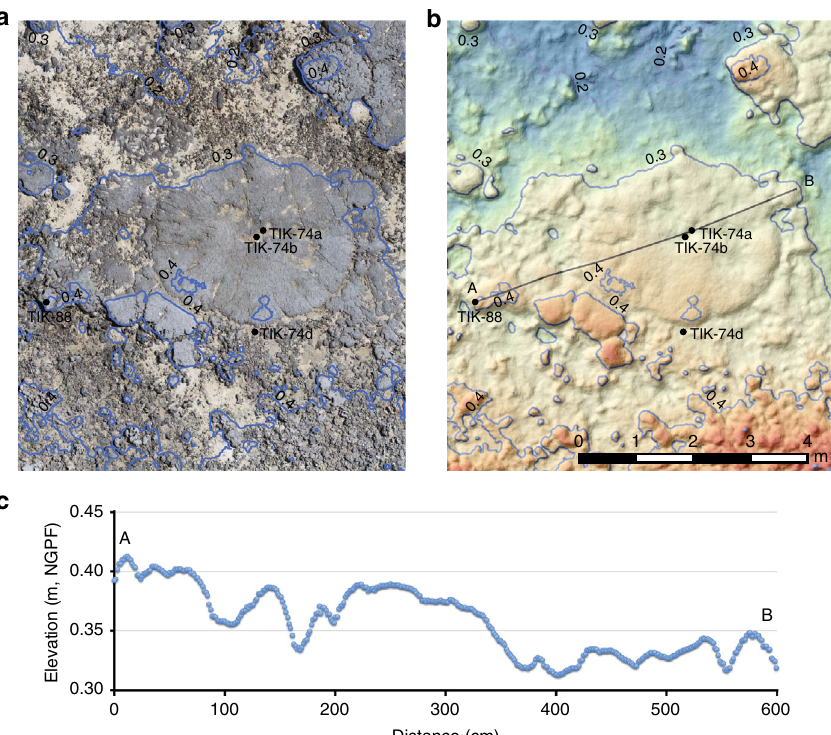
Fig. 4 Photogrammetry for a large microatoll from Tikehau. Variations of the surface elevation of a microatoll with a diameter of 8 m indicate low- amplitude, high-frequency sea-level variations on the order of 10 cm from 5.59 ± 0.05 kyr to 5.41 ± 0.08 kyr BP. 3D reconstruction with a photographic texture and b coloured texture indicating heights. Variations of the surface elevation of TIK-74 are shown in c . The numbers indicated in the fi gure correspond to elevations in metres. Agisoft Photoscan Professional version 1.2 was used to produce the 3D